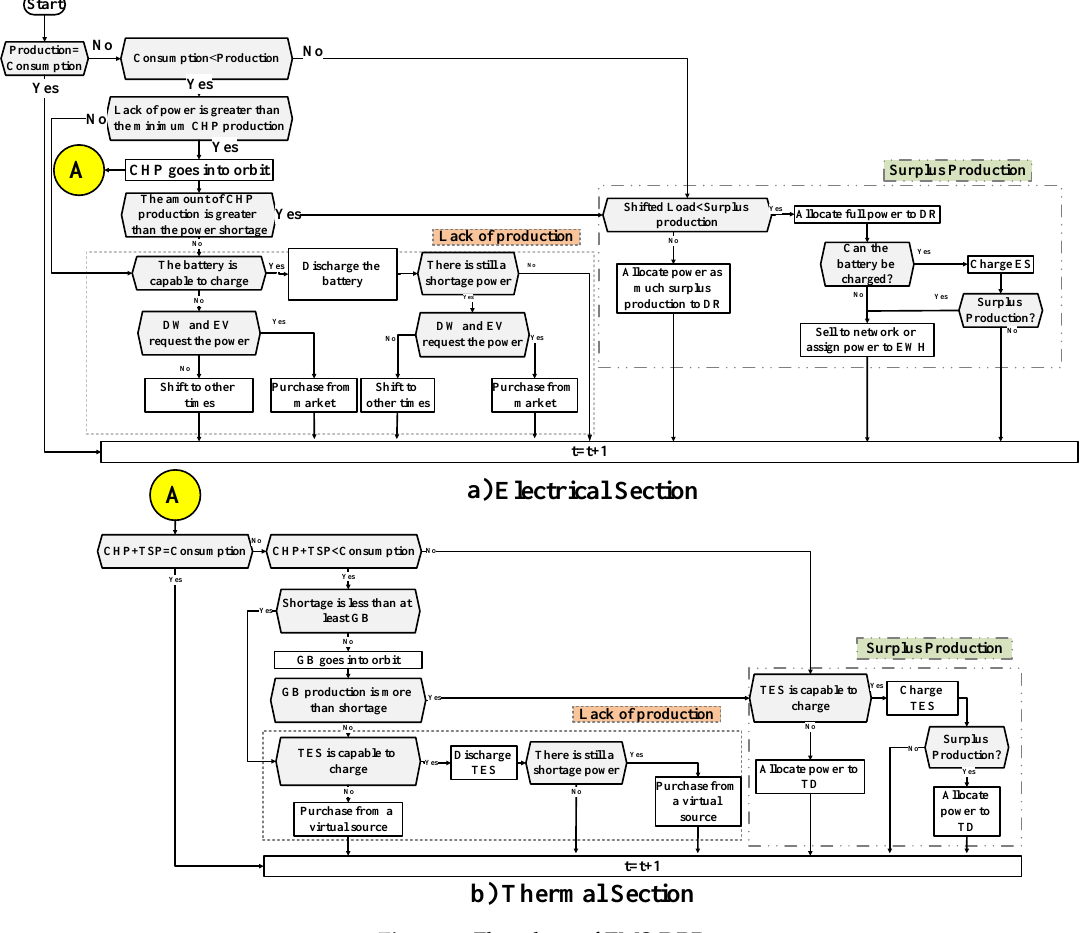
Figure 3. Flowchart of